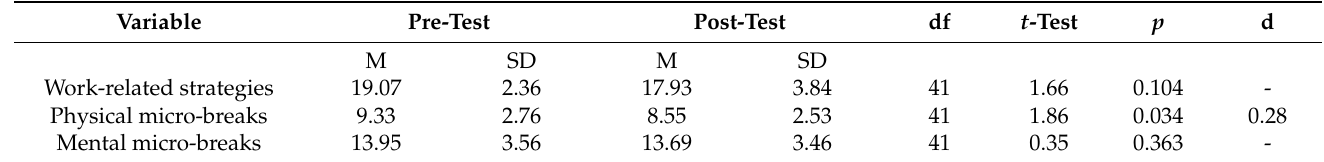
Table 3. Paired t -test results for the comparison of work-related strategies and micro-breaks (i.e., physical, mental) at the pre-test and post-test within the experimental group. Variable Pre-Test Post-Test df t -Test p d